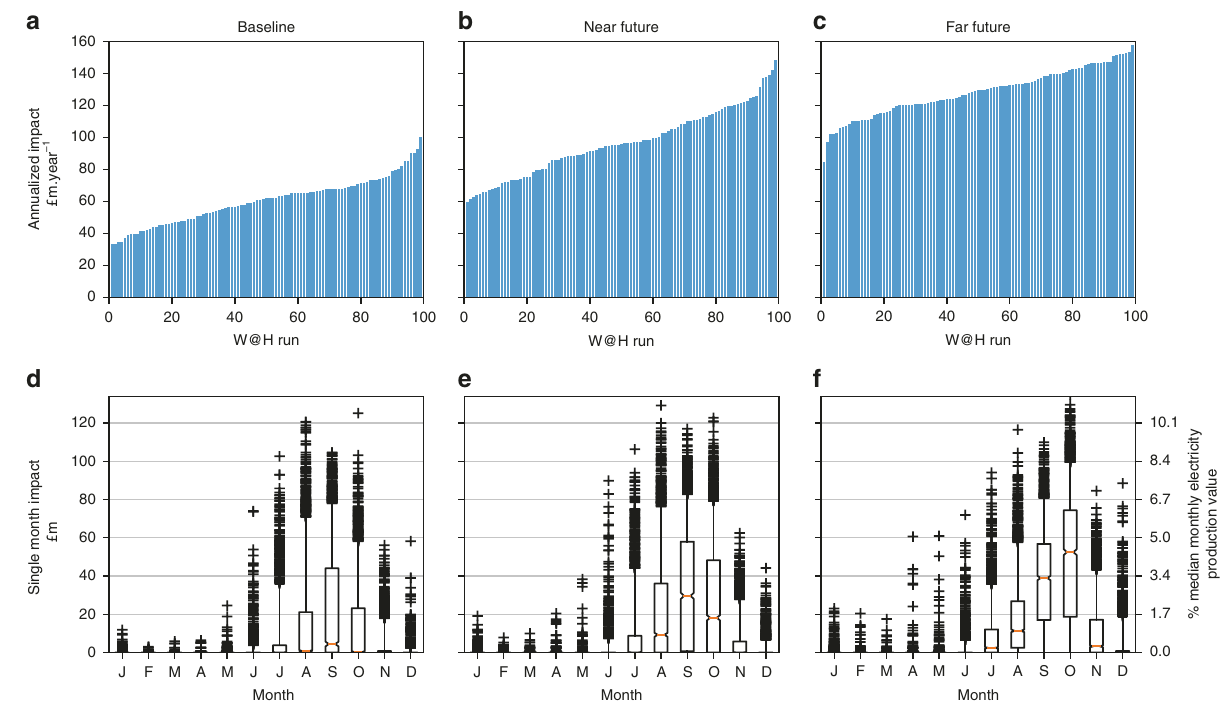
Fig. 4 Price impacts of low fl ows across the range of climate uncertainty samples. a – c The cumulative, annualised additional cost that low fl ows imparts on system electricity prices in £million per year. d – f The distribution of impacts per month. Boxplot notch is the median, the bar is the inter-quartile range (IQR), whiskers extend to 5th and 95th percentiles, dots are outside this range. Total 2900 daily samples per month. % proportion of the median monthly electricity value (second y -axis) is based on the annual median electricity production divided by